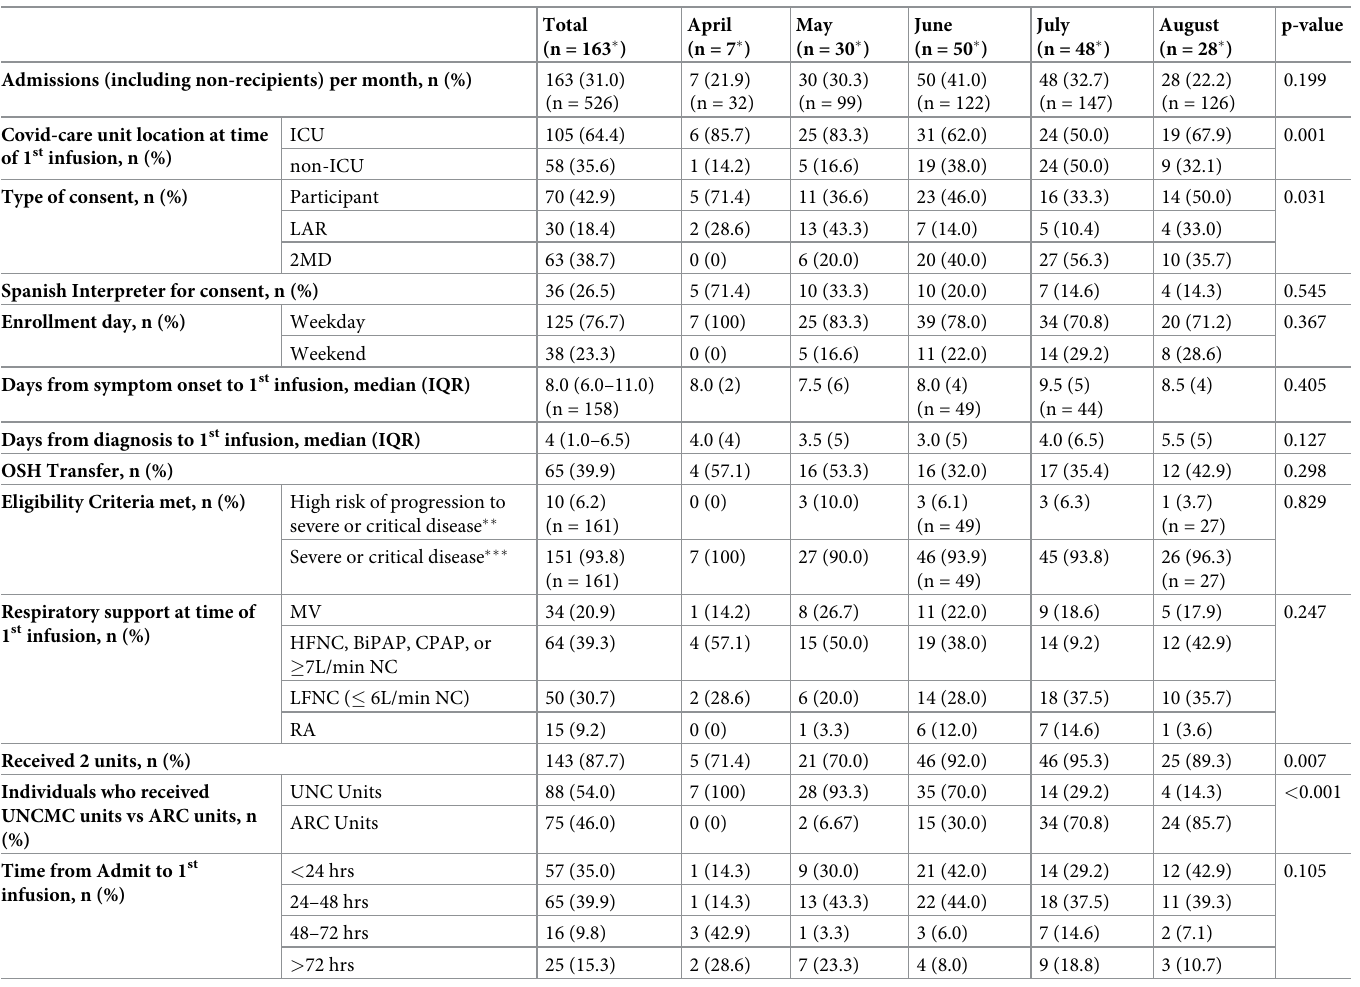
Table 3. CCP recipient